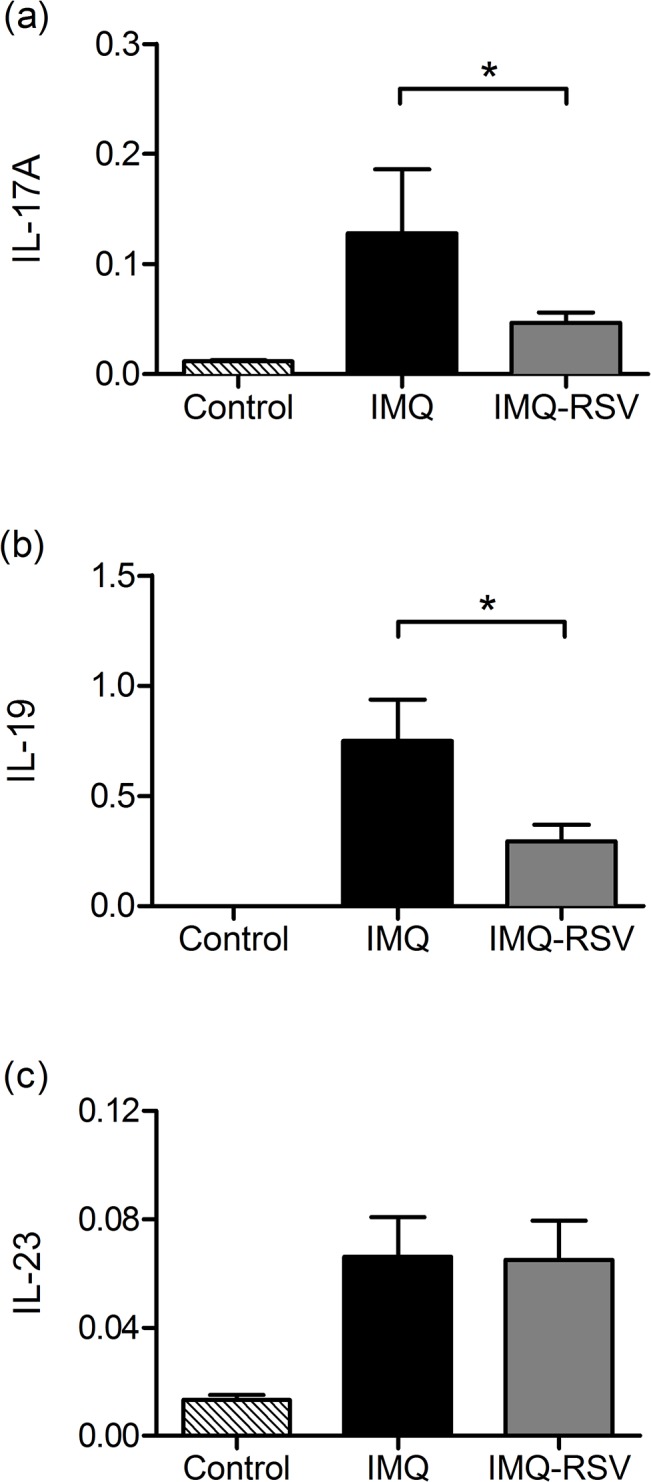
RSV effects on IL-17A, IL-19 and IL-23p19 gene expression.Quantitative PCR of IL-17A, IL-19 and IL-23p19 gene expression was determined to quantify effects of RSV on IL-17A, IL-19 and IL-23p19 gene expression. The mRNA levels of IL-17A, IL-19 and IL-23p19 were quantified using MYO18B as reference gene. Clamped bar with * above indicates the pair of column means are significantly different (p<0.05). Striped fill = control, black fill = IMQ, grey fill = IMQ-RSV.